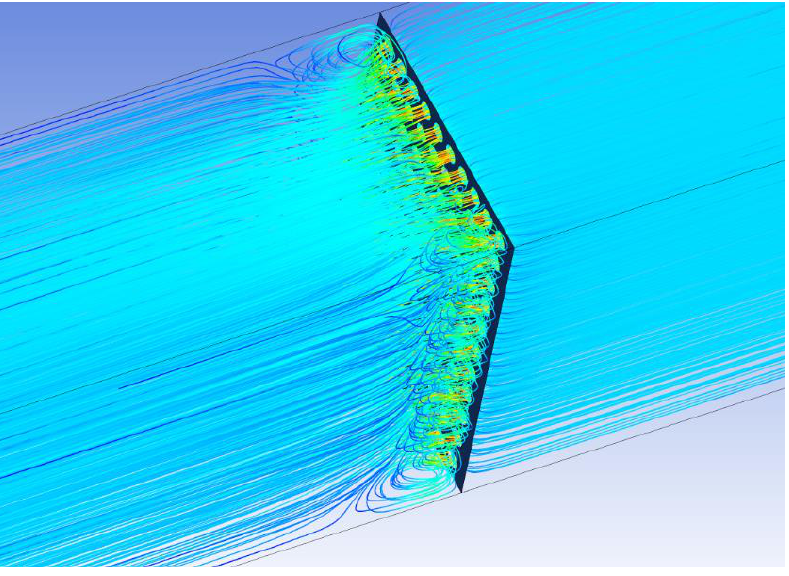
Figure 3. Pathlines inside the tunnel for Δ p BC = 145 Pa.